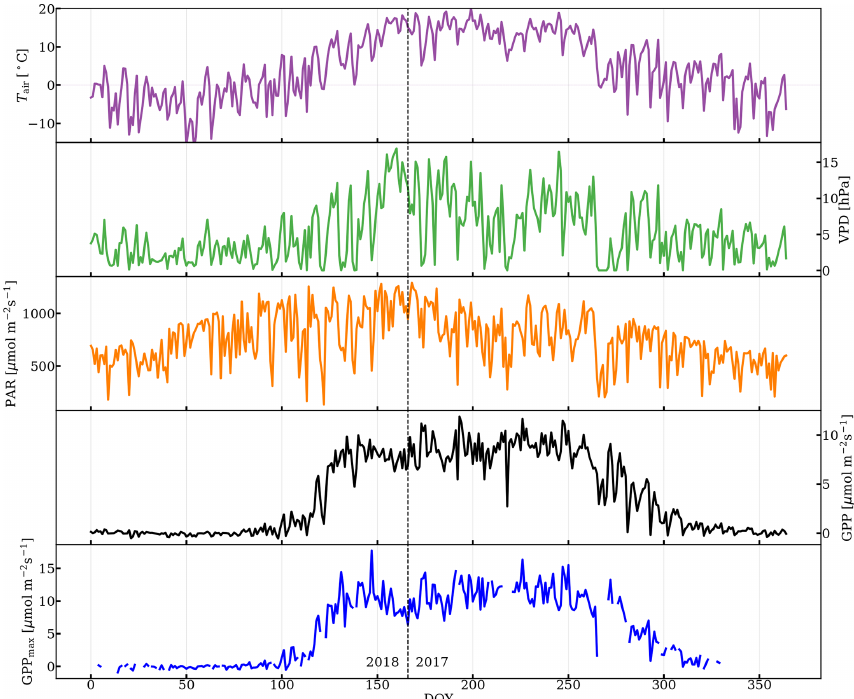
Figure 3. Daily-averaged time series of air temperature ( T air ), vapor pressure deficit (VPD), photosynthetically active radiation (PAR), gross primary production (GPP) from half-hourly data when PAR was greater than 100µmolm − 2 s − 1 , and time series of GPP max . DOY 166 (2017) was the first day of observation. The vertical dashed line divides the observations from day of year (DOY) for the years 2017 and